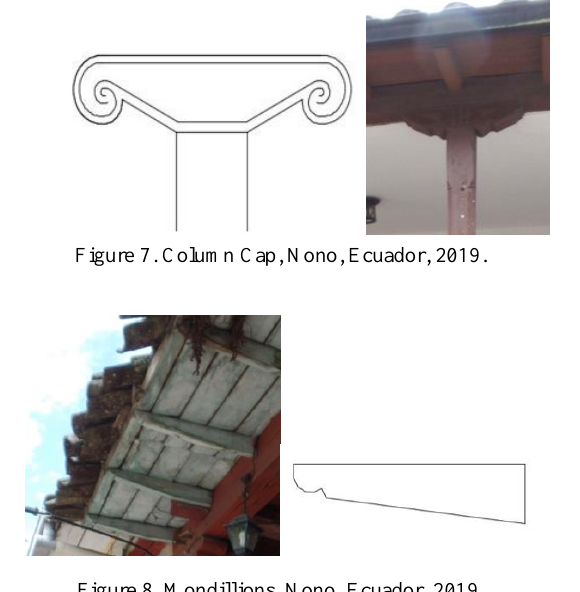
Figure 6. Interior distribution Continuous Opening type House, Nono, Ecuador, 2019.